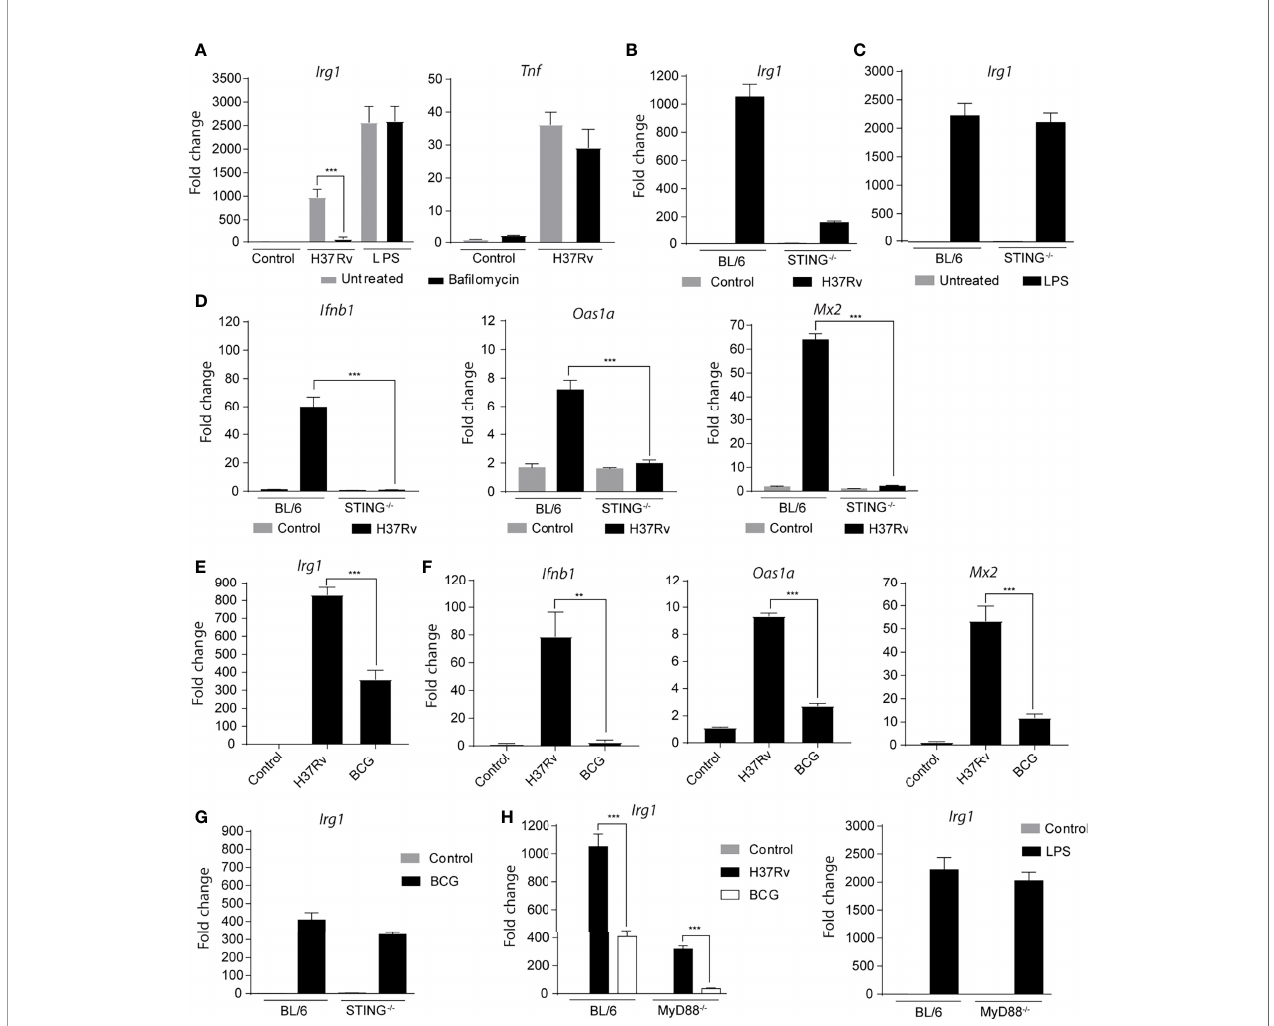
FIGURE 4 | Cytosolic sensing of Mtb is a second major signal required for Irg1 gene expression. (A) Expression of Irg1 and Tnfa at mRNA levels was evaluated in C57BL/6 BMDMs treated or not with ba fi lomycin (1 µM) and infected with H37Rv (MOI of 1) for 6 h. LPS stimulation (10 ng/ml) was used as a positive control for Irg1 and TNF- a induction in BMDM cultures. (B , C) Irg1 gene expression in STING -/- and C57BL/6 BMDMs at 6 h p.i. with H37Rv or stimulated with LPS (10 ng/ml). (D) Ifnb1 , Oas1a and Mx2 mRNA expression was assessed in STING -/- and C57BL/6 BMDM cultures infected with H37Rv (MOI of 1) at 6 h p.i. (E , F) mRNA levels of Irg1 , Ifnb1 , Oas1a and Mx2 were determined in C57BL/6 macrophages infected with H37Rv or BCG at 6 h p.i. (G) Irg1 mRNA expression was measured in BCG- infected STING -/- and C57BL/6 macrophage cultures at 6 h p.i. (H) Expression of Irg1 was determined in MyD88 -/- and C57BL/6 BMDMs infected with H37Rv or BCG strains at MOI of 1, or stimulated with LPS (10 ng/ml) at 6 h p.i. or stimulation. Statistical signi fi cance was assessed by one-way ANOVA analysis for the indicated experimental condition (**p < 0.01 and ***p < 0.001). The data are representative of at least two separate experiments